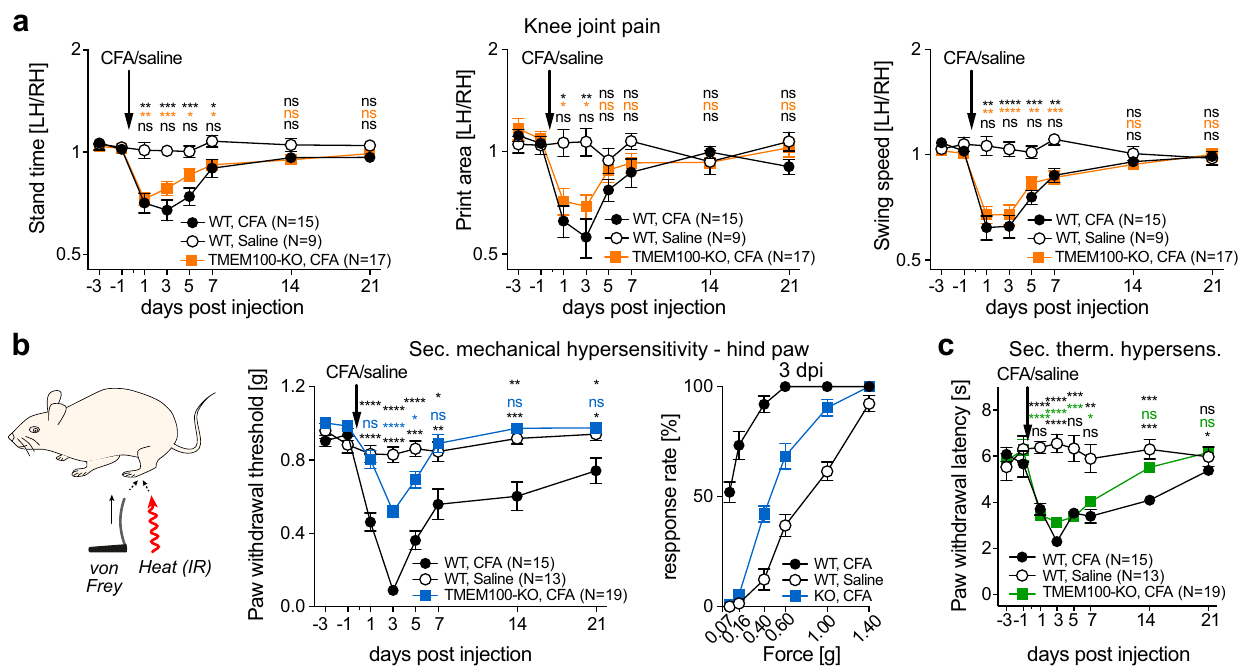
Fig. 4 | TMEM100 knock-out mice develop normal in fl ammatory knee joint pain but no long-lasting secondarymechanicalhypersensitivity. a Comparison of the time courses of changes instand time (left), foot print area (middle) and leg swingspeed(right)ofsalineinjectedWTmice(whitecircles),CFAinjectedWTmice (black circles) and CFA injected TMEM100KO mice (orange squares). b Cartoon depicting the experimental approach for measuring secondary mechanical and thermalhypersensitivityintheipsilateralhindpaw(left),timecoursesofchangesin mechanical paw withdrawal thresholds of saline injected WT mice (white circles), CFA injected WT mice (black circles) and CFA injected TMEM100KO mice (blue squares) (middle) and responsiveness of WT mice (white circles),CFA injected WT mice (black circles) and CFA injected TMEM100KO mice (blue squares) three days post saline/CFA injection (3 dpi) to all tested von Frey fi laments (right). Response rates were compared using 2-way ANOVA. P -values of multiple comparisons are as follows: WT-saline vs. WT-CFA, P 0.07g =7.5E-08, P 0.16g =2.8E-08, P 0.4g =8.7E-12,